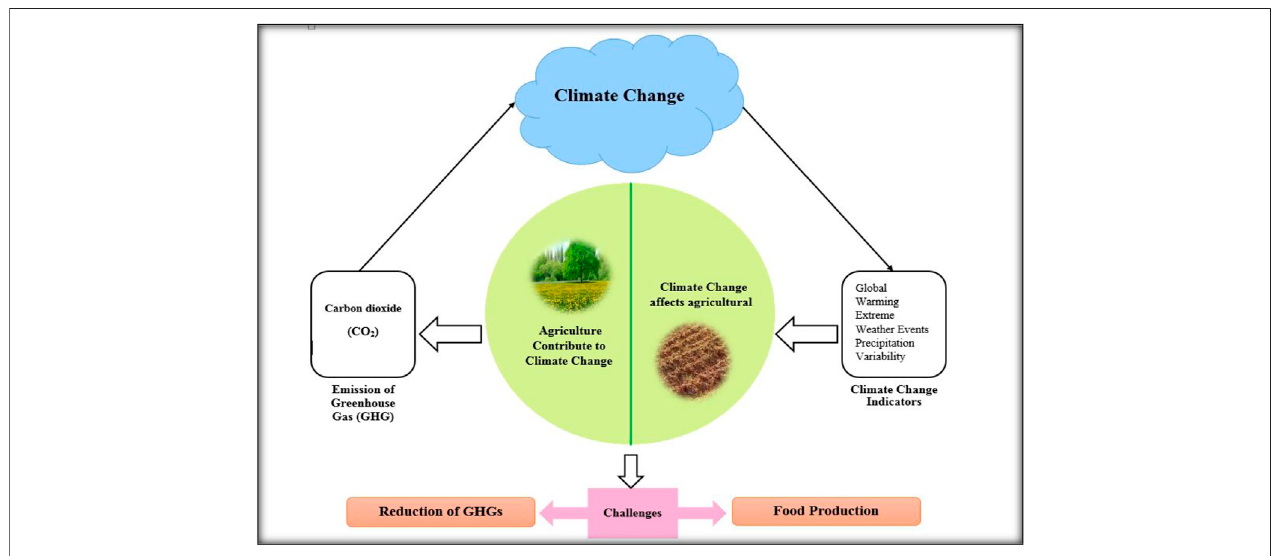
FIGURE 1 | Agricultural productivity and climate